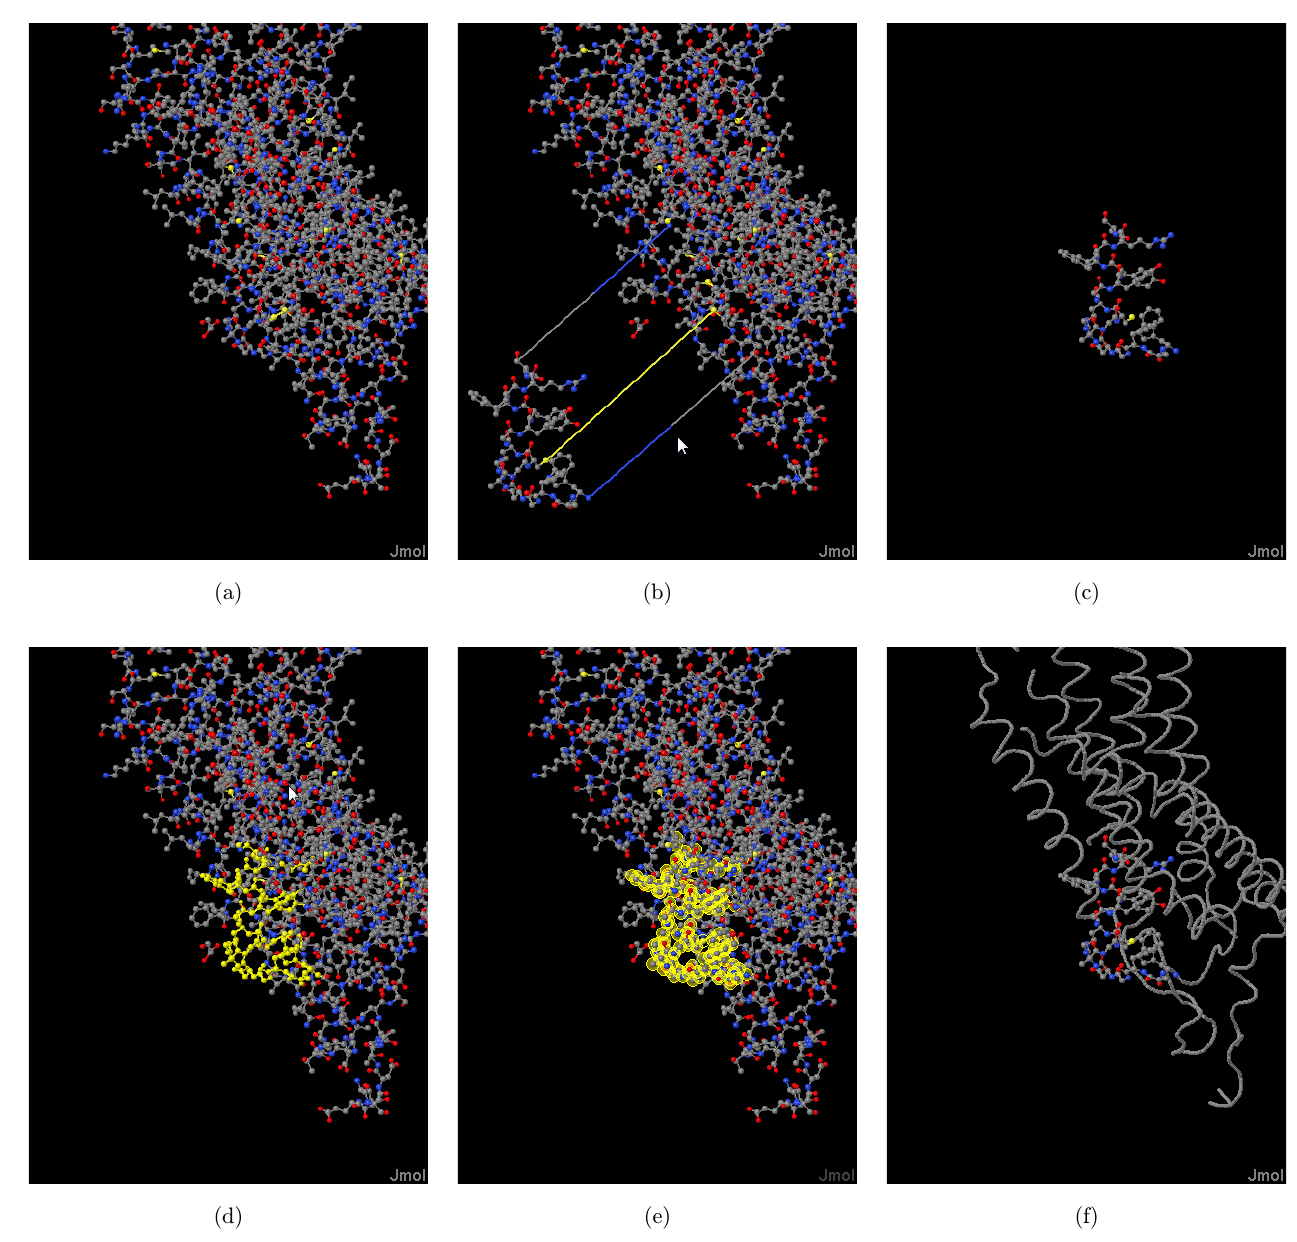
Fig. 1. Examples of 3D interaction means of inspecting local regions provided by traditional tools. (a) Original status of a molecular 3D structure (PDB ID: 5T04) in a 3D scene. (b) The selected region can be translated out of the main body of the molecule by mouse interaction. (c) The unselected regions can be hidden. (d) The selected region can be highlighted in a di®erent color. (e) The selected region can be haloed. (f) Apart from the selected region, other regions can be changed into Trace